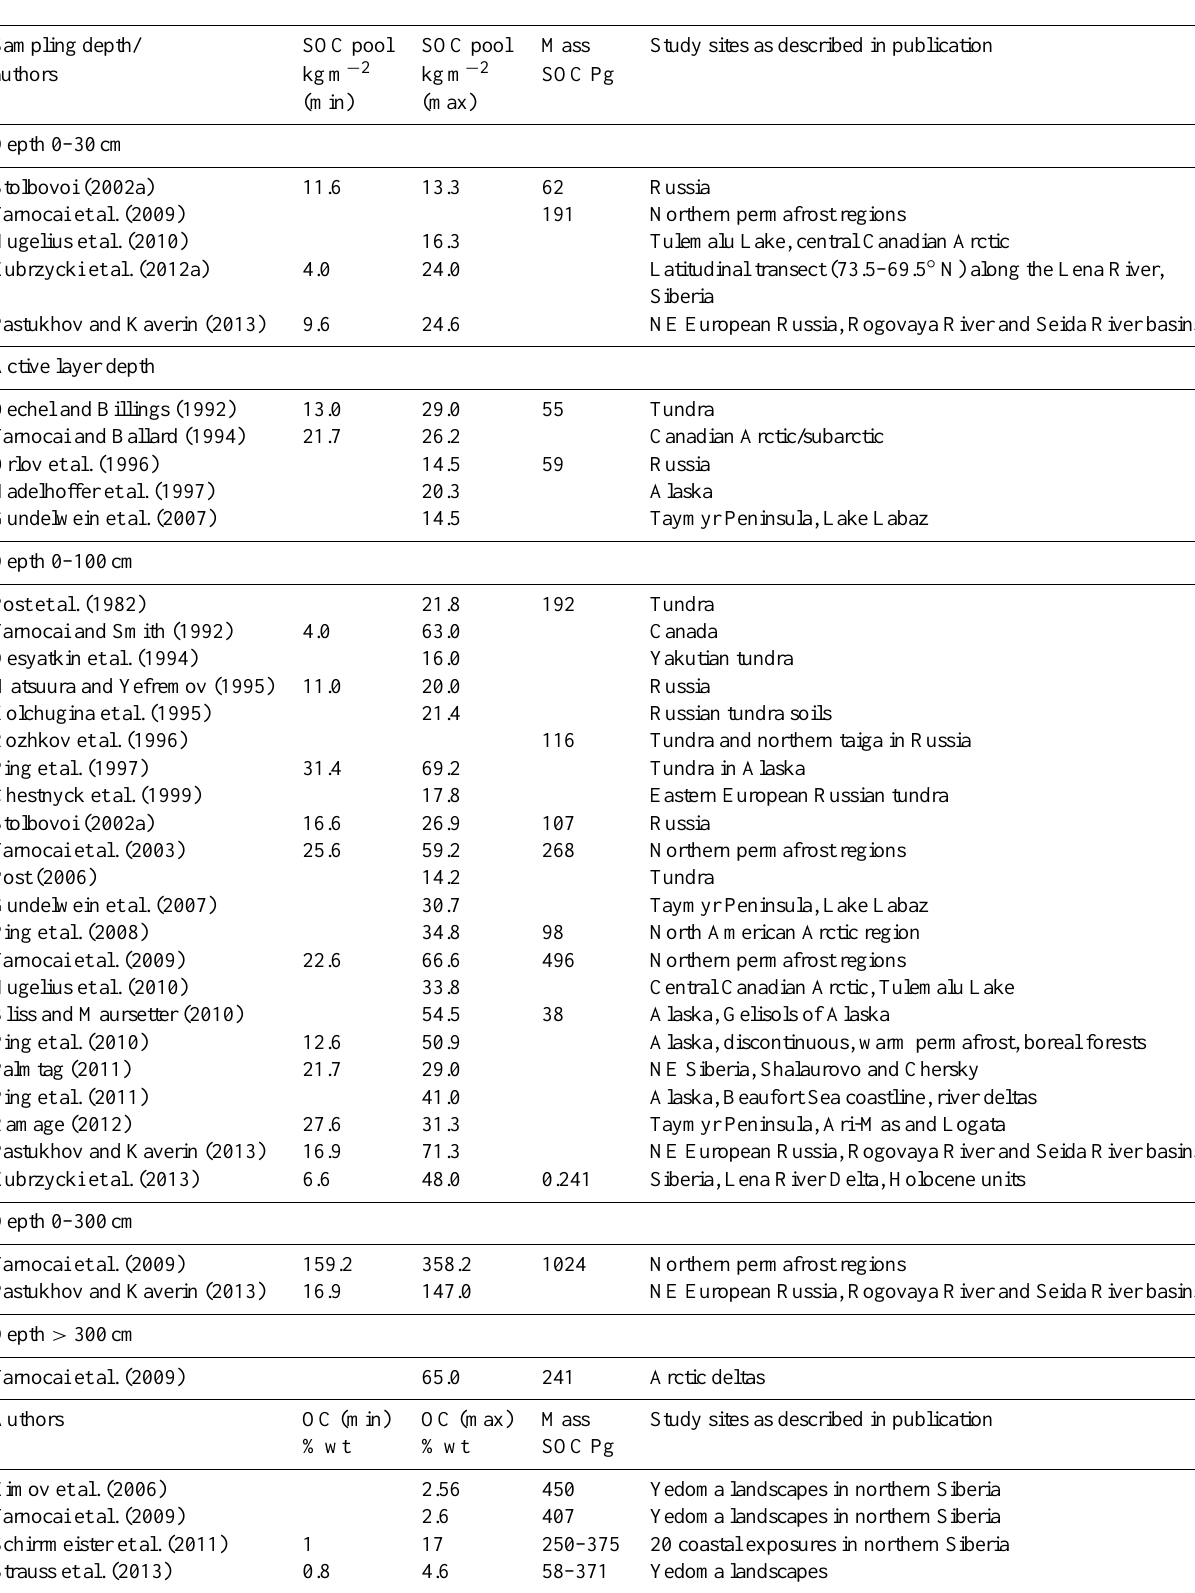
Table 1. Overview of carbon studies from different permafrost regions. Only results related to the permafrost-affected soils are presented. This list shows only some examples and is not intended to be exhaustive. SOC stands for soil organic